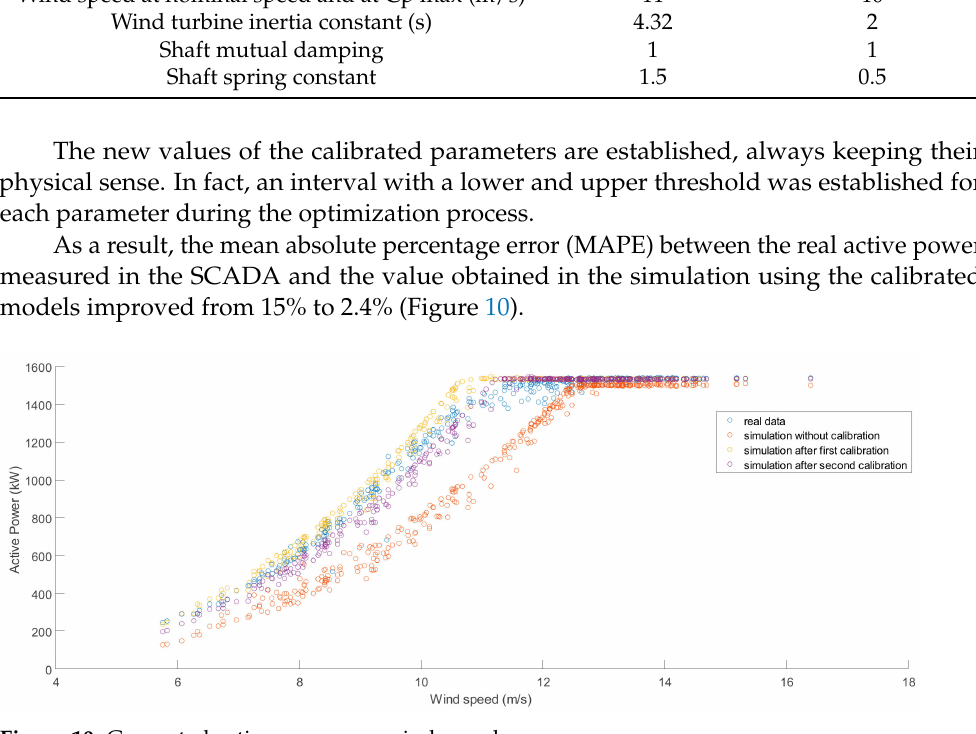
Figure 10. Generated active power vs. wind